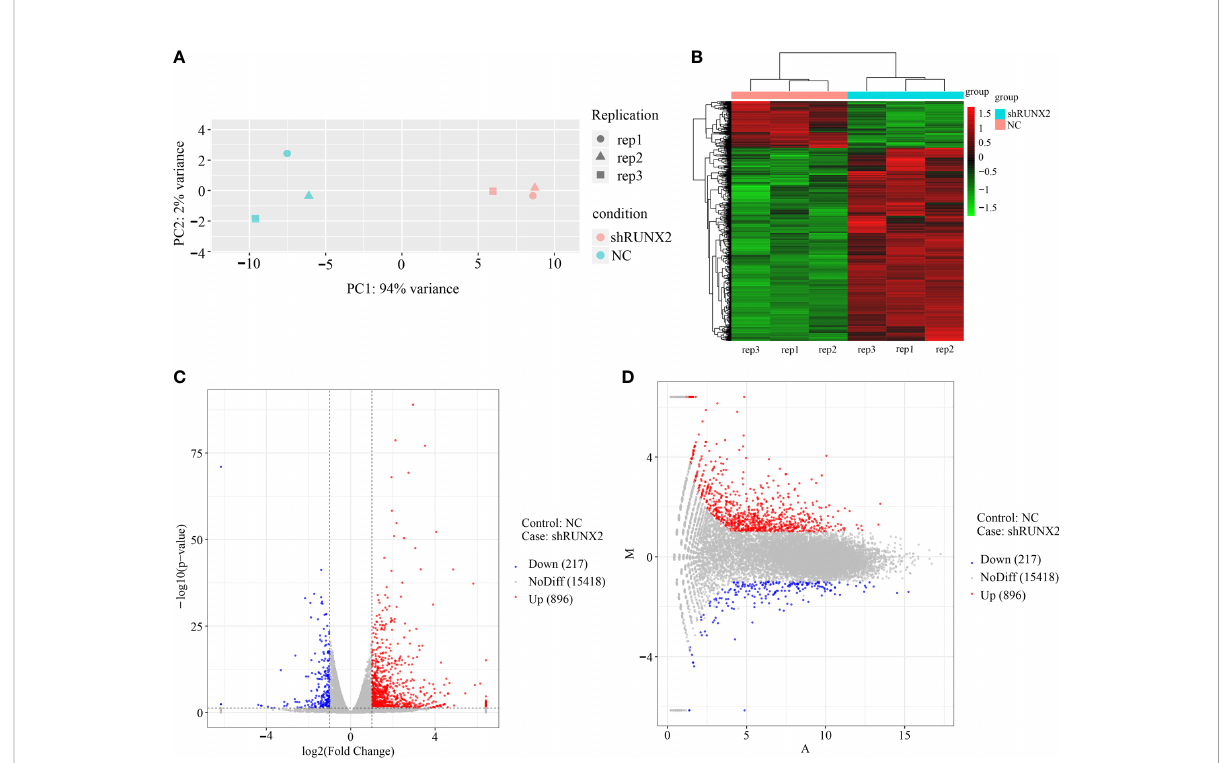
FIGURE 5 Gene expression pro fi ling and DEGs in shRUNX2 and NC MDA-MB-231-Re cells. (A) Principal component analysis (PCA) of the three replications of shRUNX2 and NC MDA-MB- -231-Re cells. (B) Hierarchical cluster analysis of the DEGs in shRUNX2 and NC MDA-MB-231-Re cells. (C, D) Volcano plots (C) and MA plots (D) of the total genes expressed in shRUNX2 and NC MDA-MB-231-Re